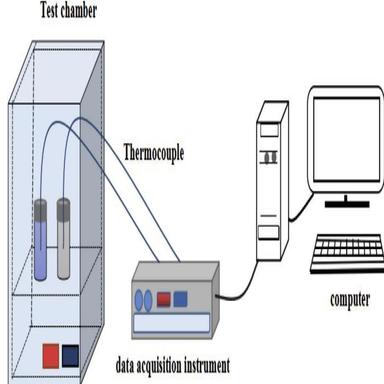
A schematic of recording solidification process of CaCl2·6H2O with different mass ratio of CsxWO3 nanoparticles.